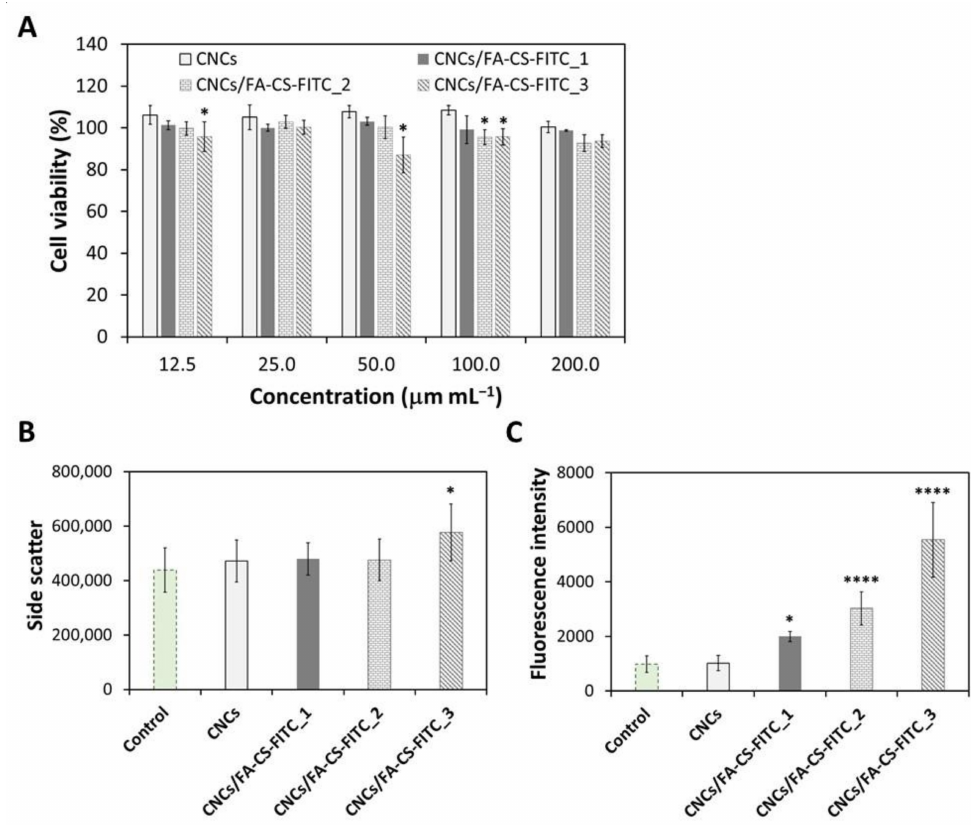
Figure 4. ( A ) Cell viability of the MDA-MB-231 cells after 24 h of exposure to the pristine CNCs and CNCs/FA-CS-FITC nanosystems, and flow cytometry data: ( B ) side-scattered light and ( C ) side- fluorescence light of the pristine CNCs and CNCs/FA-CS-FITC nanosystems for 24 h (the symbols * and **** epitomize the means with a significant difference from the control at p < 0.05 and p < 0.0001 levels,